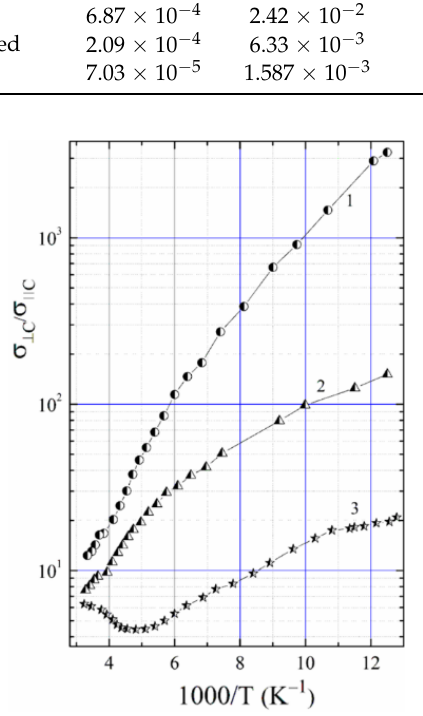
Figure 7. The out-of-plane electrical conductivity (i.e., across the van der Waals layers) versus tem-